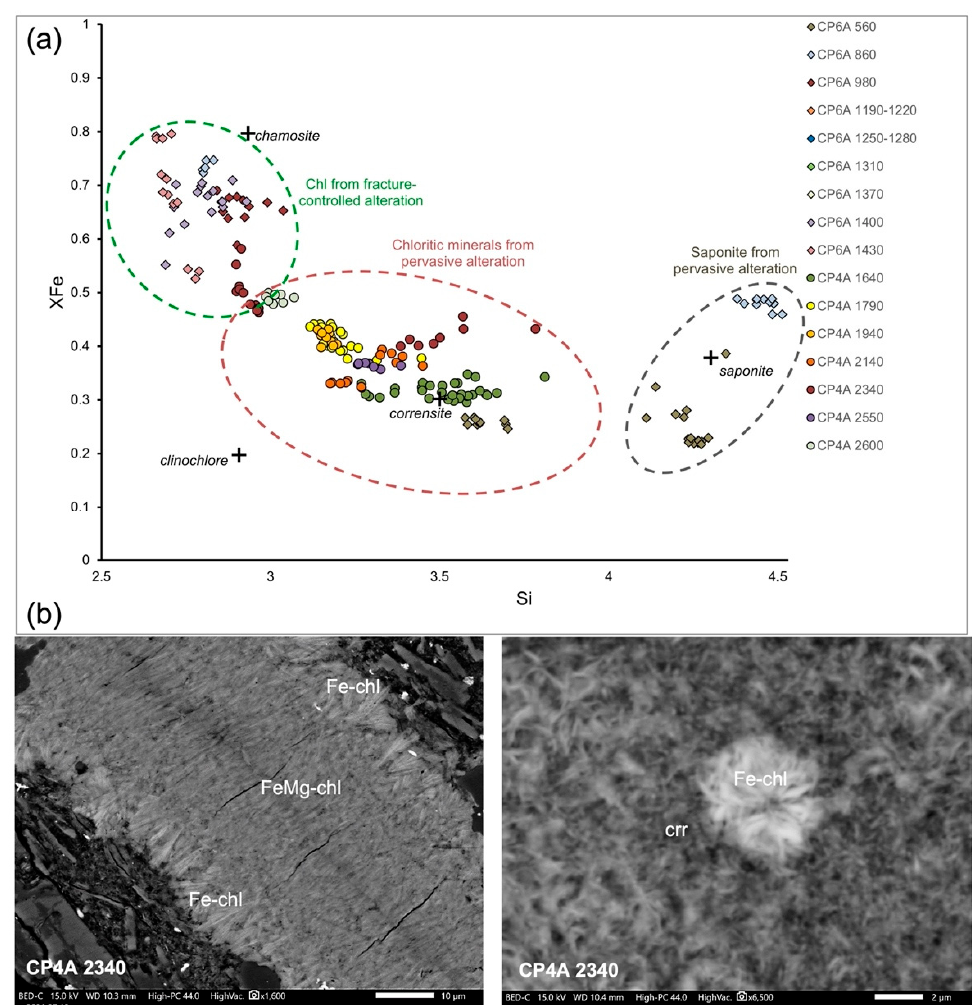
Figure 7. ( a ) Plot of the structural formulae of trioctahedral clays in a diagram of XFe versus Si for CP-4A and CP-6A wells (XFe = Fe/(Fe + Mg). The average structural formula for each sample is presented in S1. In this figure, all the samples are represented with a relative structure containing 14 oxygen atoms and assuming that the total iron content was composed of Fe 2+ . Theoretical compositions of clinochlore, chamosite, corrensite, and saponite are provided for reference. ( b ) SEM observations of Fe-chlorite from the fracture-controlled alteration superimposed to the Fe-Mg chlorite and corrensite from the pervasive alteration.